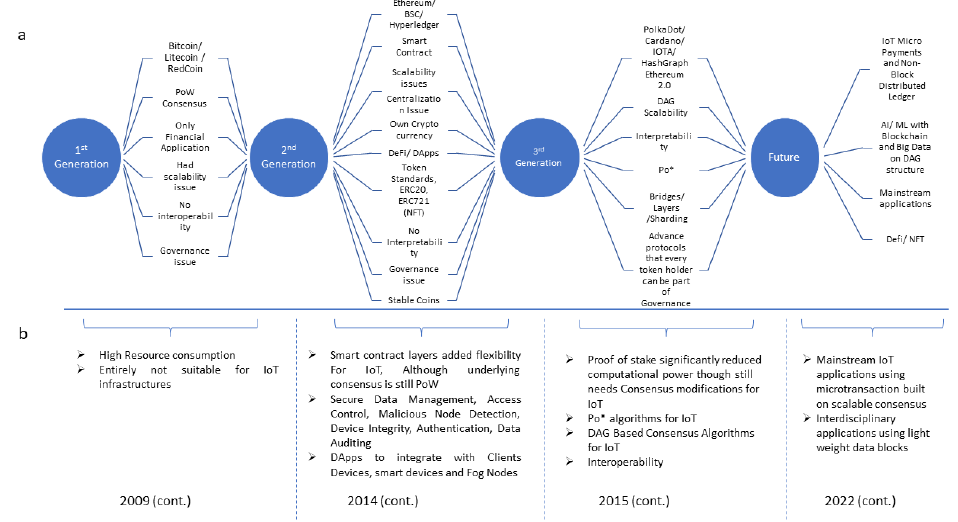
Figure 2. ( a ) Blockchain generations; ( b ) consensus evolution along